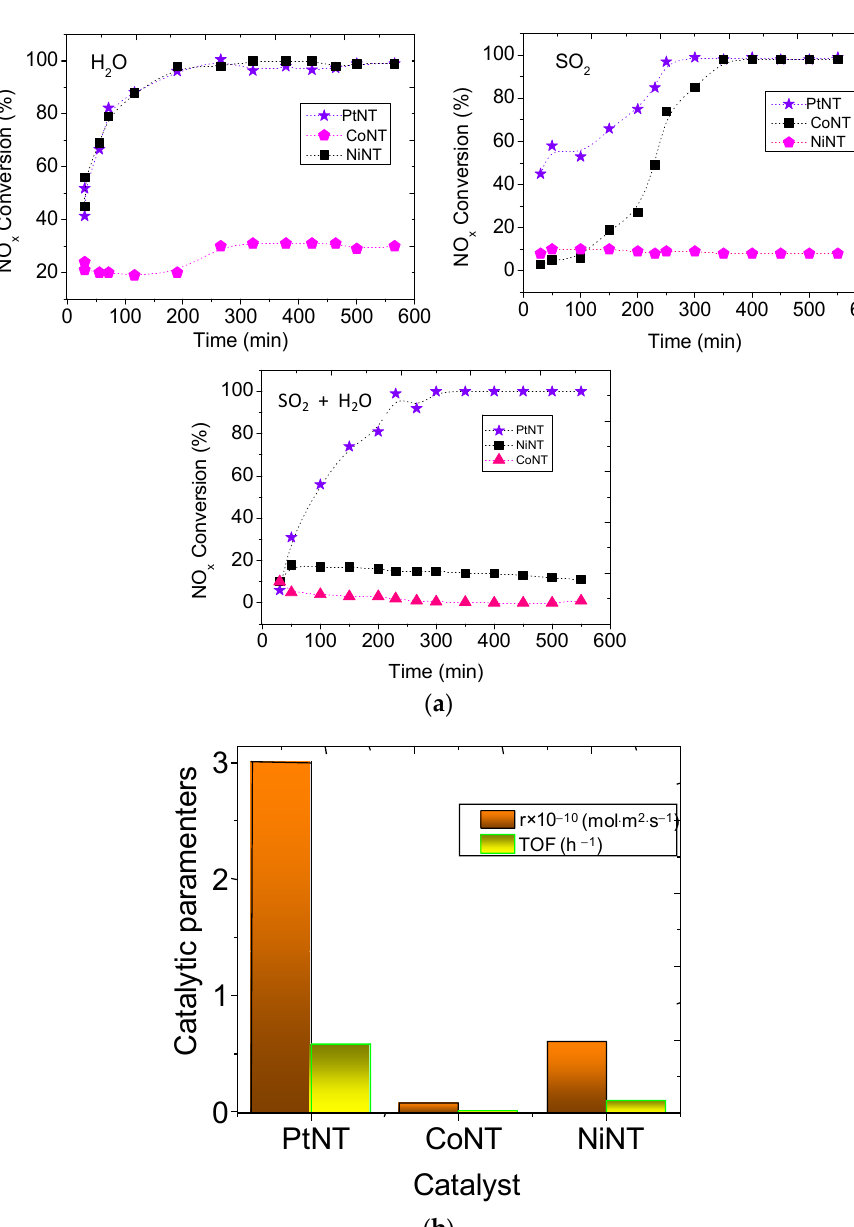
Figure 7. ( a ) Effects of the SO 2 and water vapor poisons (or both) on the catalytic performance of the solids. Reaction conditions: amount of the catalyst, 0.15 g; reaction gas mixture, 500 ppm of NO, 1000 ppm of CO and balance in He; flow rate, 80 mL·min − 1 ; space velocity, 48,000 h − 1 . Either 10 wt% ( v/v ) of water vapor or 50 ppm of SO 2 (or both) was used during the reaction at 250 °C for 600 min. ( b ) Catalytic parameters determined in 6 h after the exposition of the solids to the SO 2 and water vapor poisons.